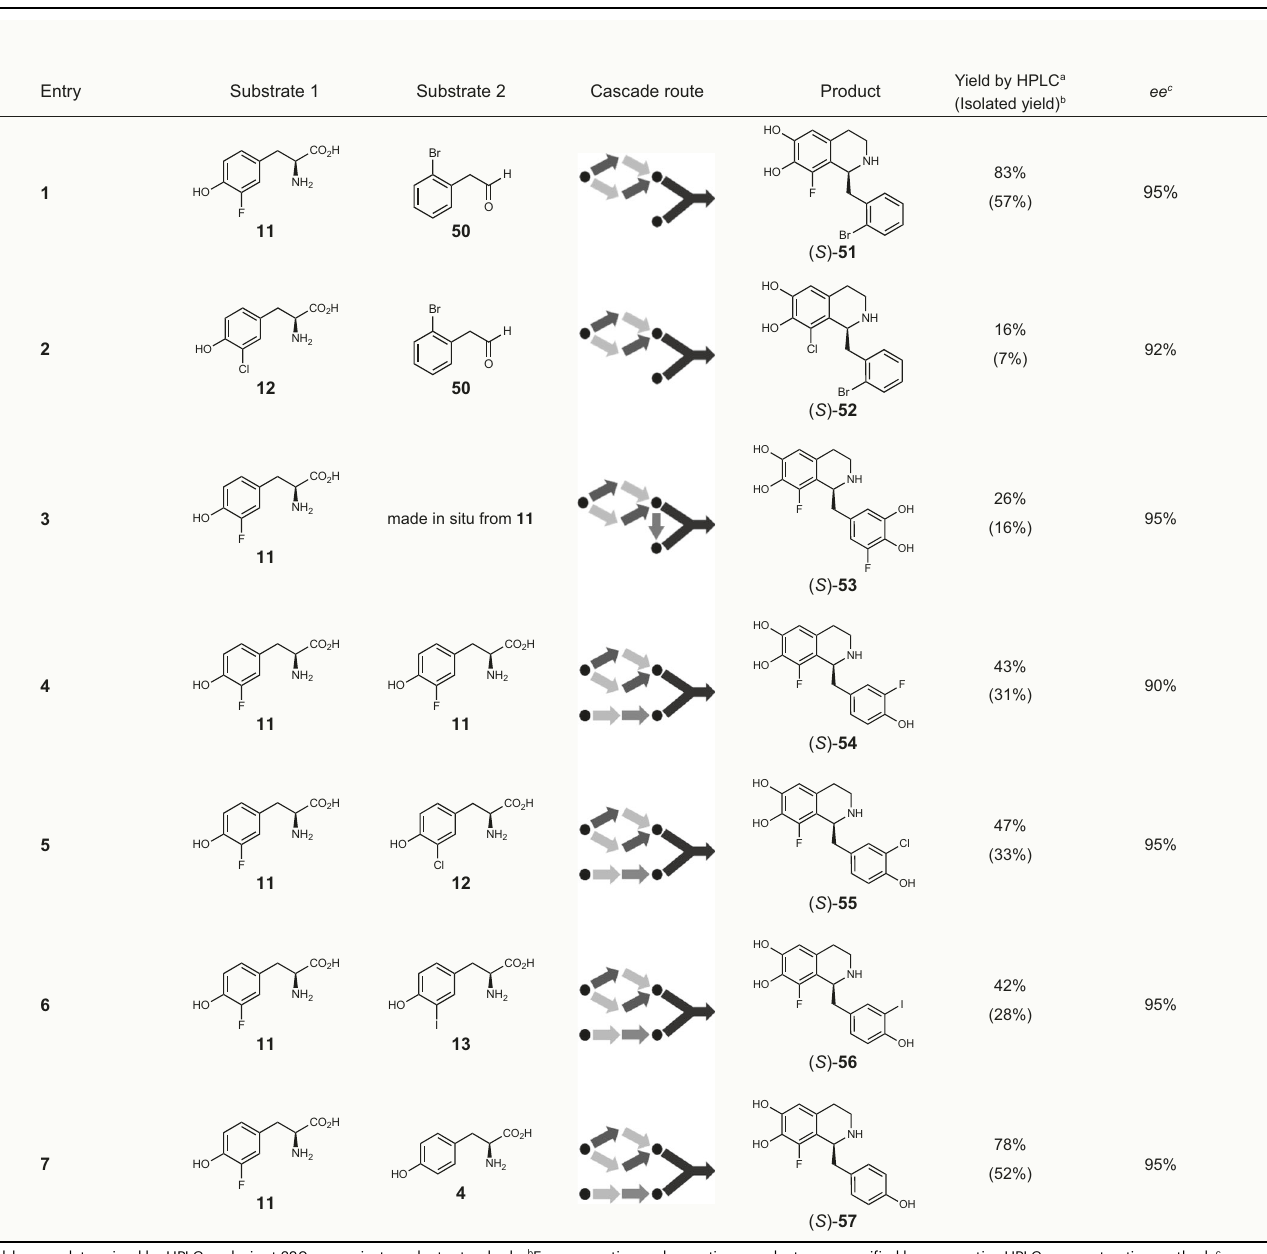
Table 4 | Parallel cascades with Cn TYR variants, Ef TyrDC, Cv TAm, and Tf NCS-A79I to halogenated BIAs